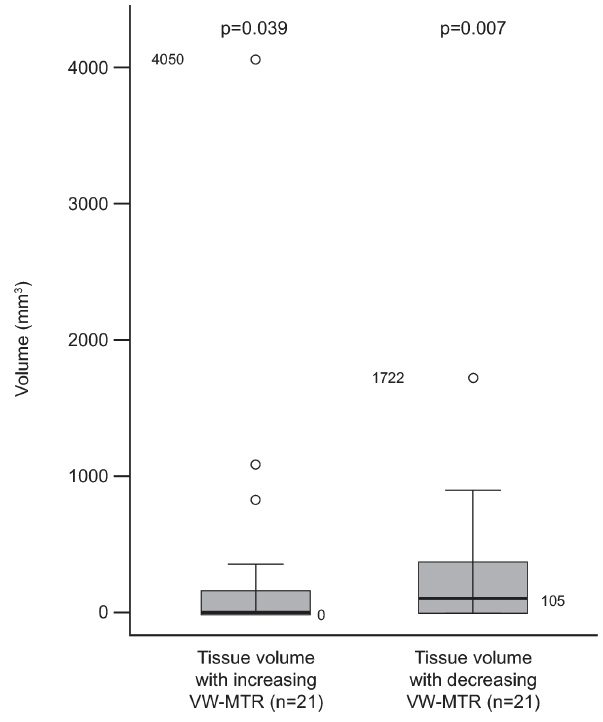
Figure 4. Difference from baseline to 24 weeks for increasing and decreasing VW-MTR in T2-LV in patients. The p-value is for the difference from zero within groups from the Wilcoxon signed–rank test with adjustment. In the box plot, the bold line represents the median; the boxes represent the middle 50% of data; the top and bottom of the box represent the third and first quartiles; the open circles are outliers. The whisker lines above and below the boxes represent the largest and smallest values that are not considered to be outliers. LV, lesion volume; NS, not significant; VW-MTR, voxel-wise magnetization transfer